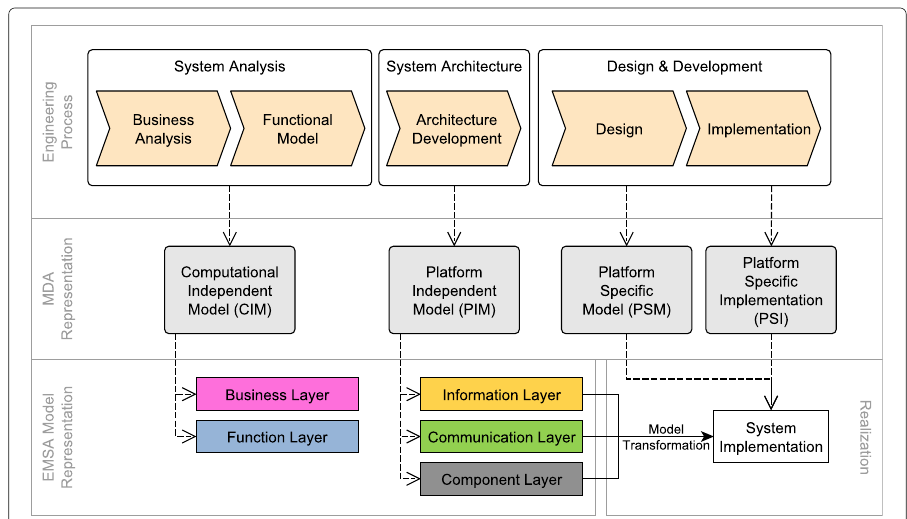
Fig. 9 MDA engineering process mapped to EMSA Model, based on Dänekas et al. (2014); Uslar et al.